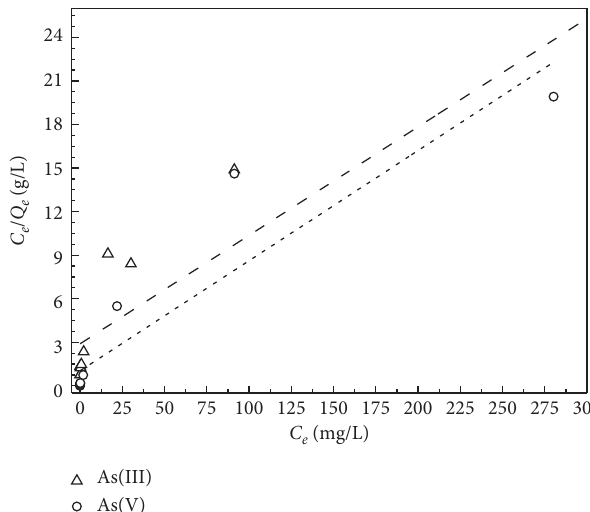
Figure 12: Langmuir model plots for the adsorption of As(III) and As(V) at pH � 8, adsorbent dosage 0.5 g, and initial arsenic con- centration 1.3